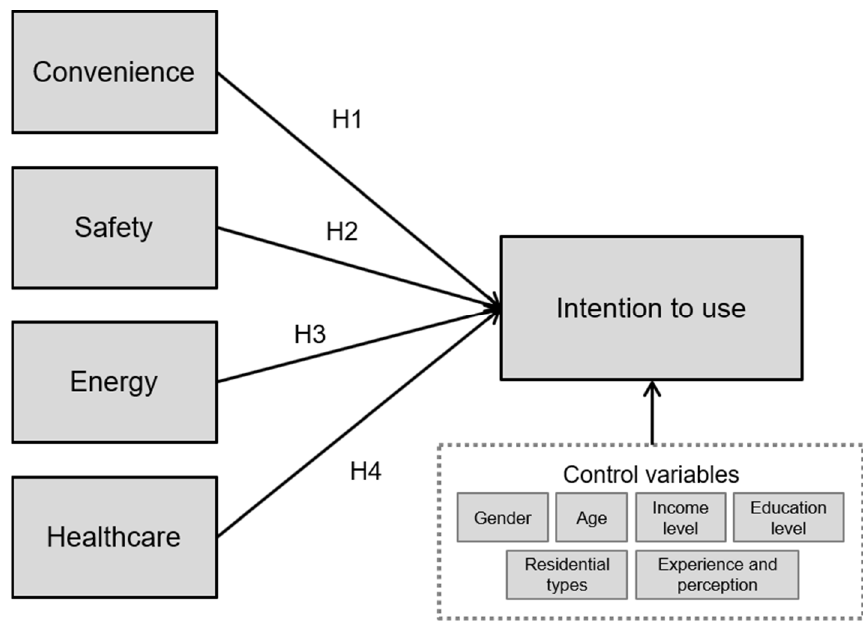
Figure 1. Research model and hypotheses.